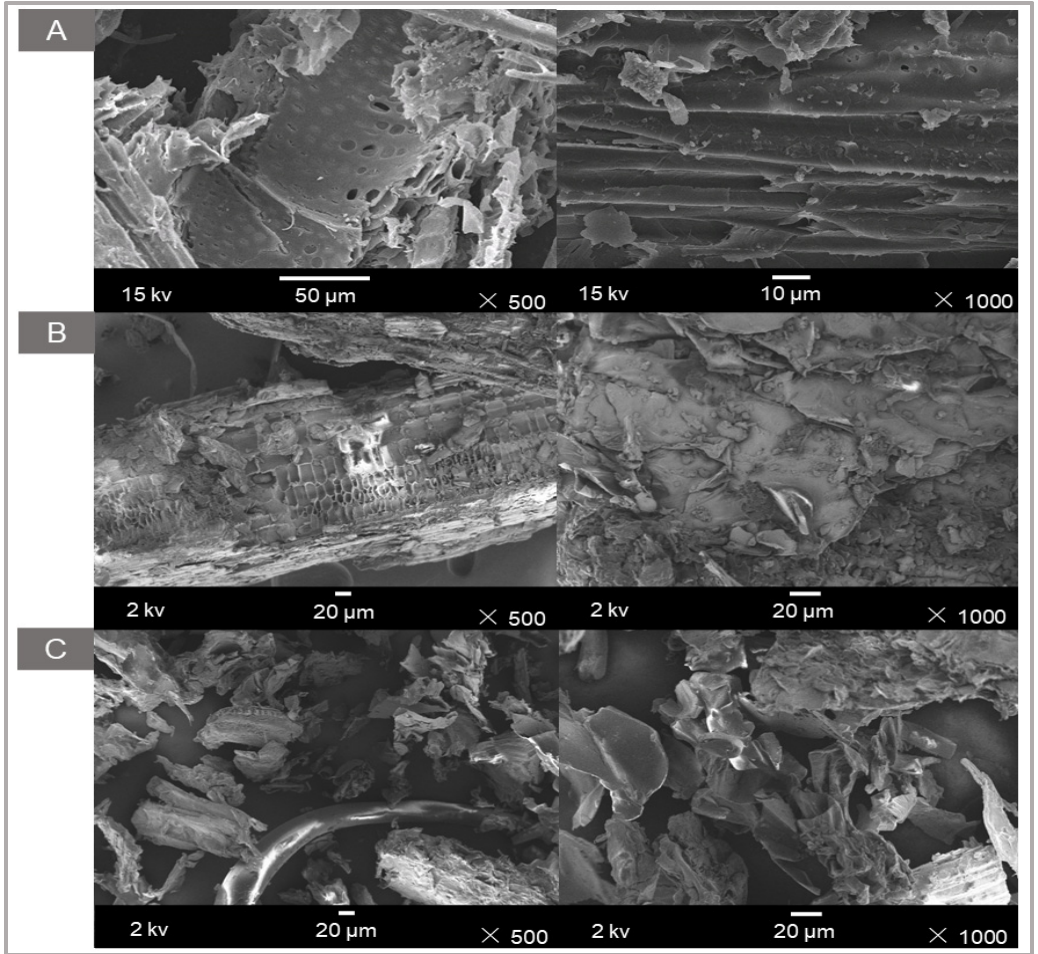
Figure 3. SEM images of: ( A ) pine sawdust, ( B ) sunflower seed hulls, ( C ) corn residues mix.